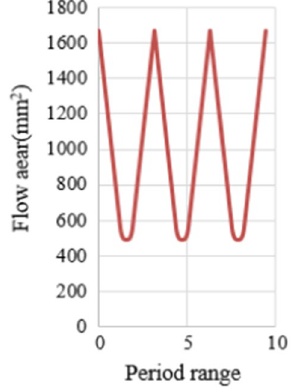
Figure 6. The change rules of flow area.